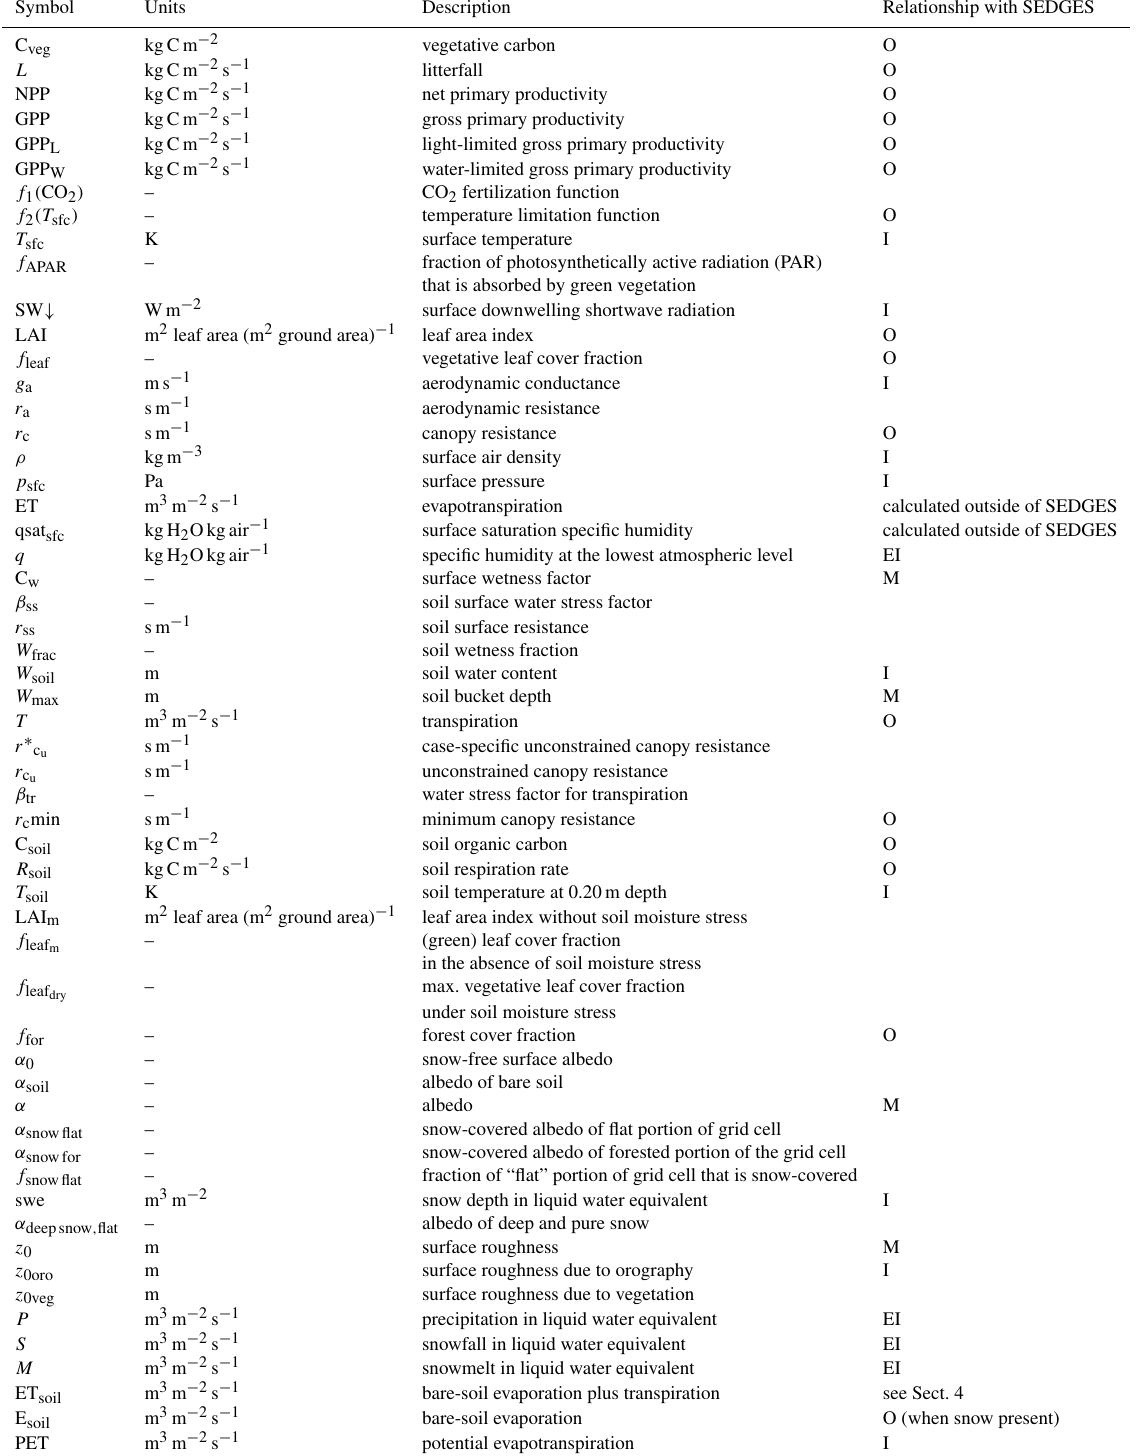
Table 1. SEDGES variables in the paper. Notation for the rightmost column is as follows: “I”, “O”, and “M” indicate variables that are, respectively, input to, output by, or modified by the SEDGES model. A blank field in that column indicates that the variable could be output if desired, but some code changes would be needed. “EI” denotes a variable from ERA-Interim that is used by the simple land surface scheme that we use to drive SEDGES with in Sect. 4. We denote by “M” only those output variables that are output by SEDGES that are expected to be already existing in the land surface scheme in which SEDGES is